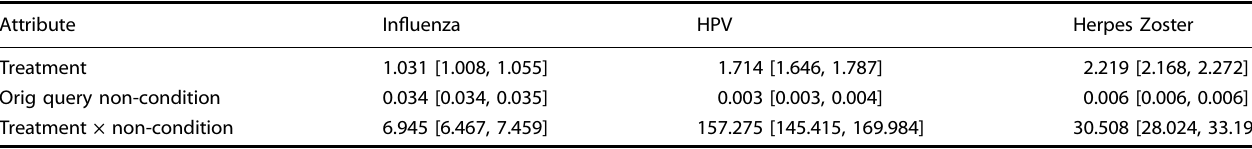
Table 3. Hazard ratio of a Cox hazard model of post-ad vaccine searches. Numbers shown are hazard ratios.